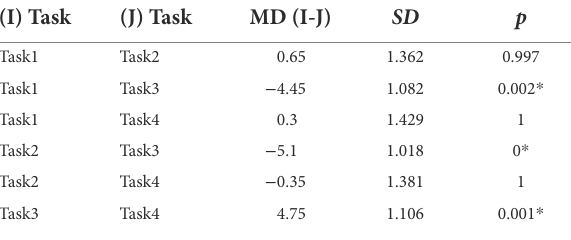
TABLE 3 Multiple comparisons between Task1/2/3/4 within the NOEE group.